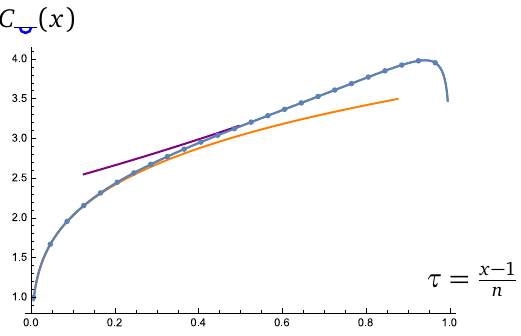
Figure 2: The correlation function C ( x ) for ϕ = 1. The points are the exact values for n = 200. The blue, yellow and purple solid curves are respectively drawn from (3.28), (3.29) and